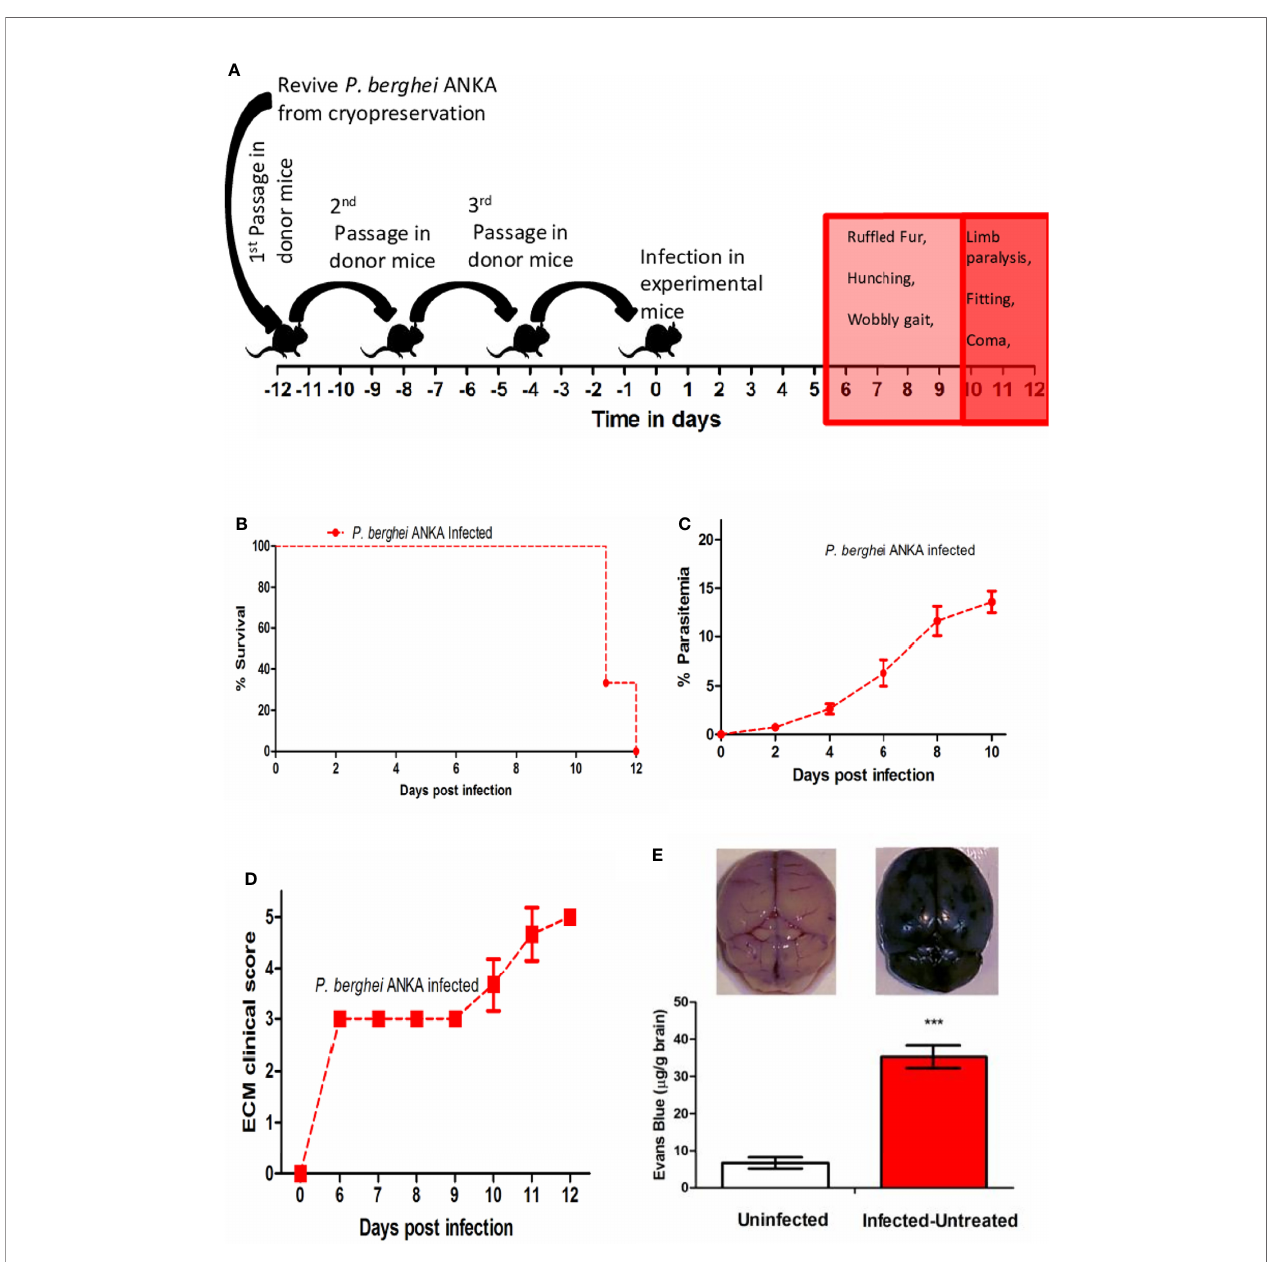
FIGURE 2 | (A) Schematic for establishment of ECM in C57BL/6 mice. (B) Survival curve (C) Trend in parasitemia and (D) ECM clinical score of P. berghei ANKA infected C57BL/6 mice. Data is representative of 3 independent experiments (E) Quantitation of Evan ’ s Blue Dye extravasation in the brain of Uninfected vs Infected- untreated mice on day 10 p.i. Data is expressed as mean ± SD from 3 mice per group. [* P <0.05, ** P <0.01, *** P <0.001, n.s., not signi fi cant].